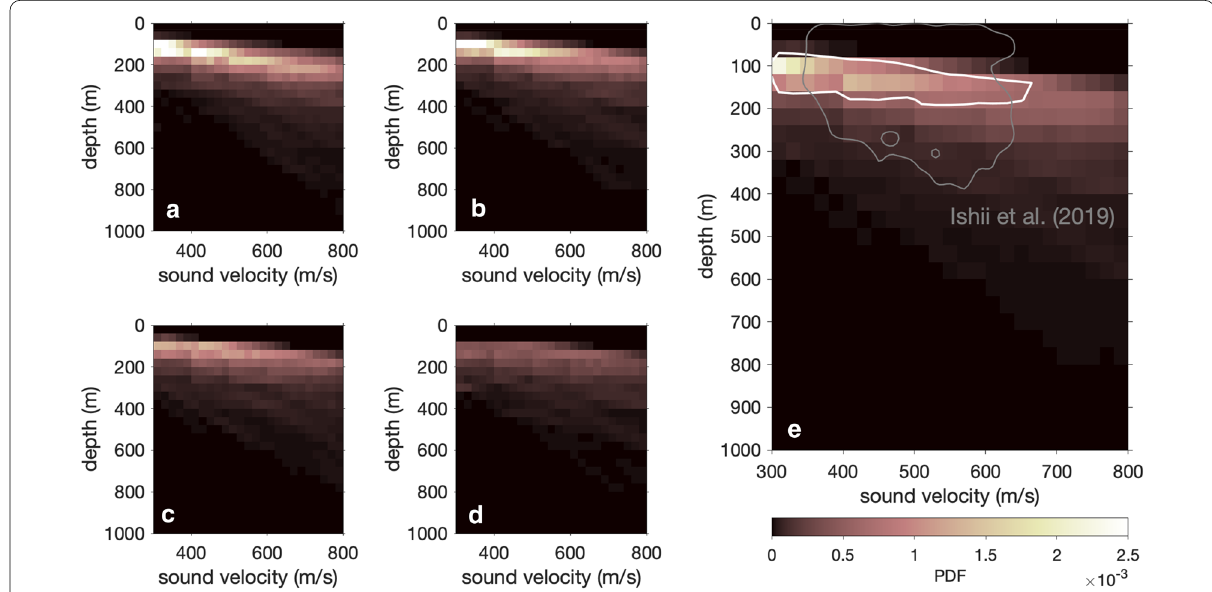
Fig. 5 2-D PDFs of two estimated unknown parameters. These unknowns are the depth of the magma–air interface and the sound velocity inside the vent. a–d PDFs assuming four frustum pipe radii ( a c = 35, 46, 58, and 71 m, respectively). The results generally indicate that large PDF values are distributed at shallower depths (<200 m) and over wide sound velocity ranges. e Summed PDFs of these four results. The four PDF values are multiplied by the weighting coefficient of each shape, as determined from the observed PDF of f 1 / f 0 (Fig. 2b) at the time of summation. The total PDF value in the region surrounded by a white line is equivalent to half the whole area. This region is at a depth of 40–200 m and a sound velocity of 300–680 m/s. The thin gray line is the estimated range from the previous study using only the time delay of arrivals (Ishii et al.